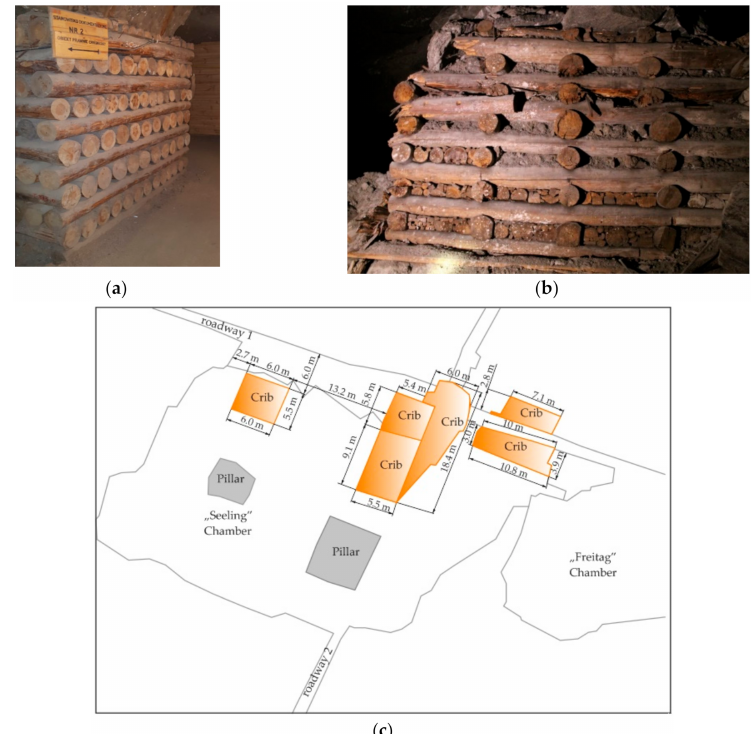
Figure 1. Wooden support of chamber excavations in salt mining: ( a ) Round wooden crib made of round beams, full in the Bochnia Salt Mine; ( b ) Wooden crib filled with gangue in the Wieliczka Salt Mine; ( c ) Protection of “Seeling” Chamber by means of wooden cribs in the Wieliczka Salt Mine.